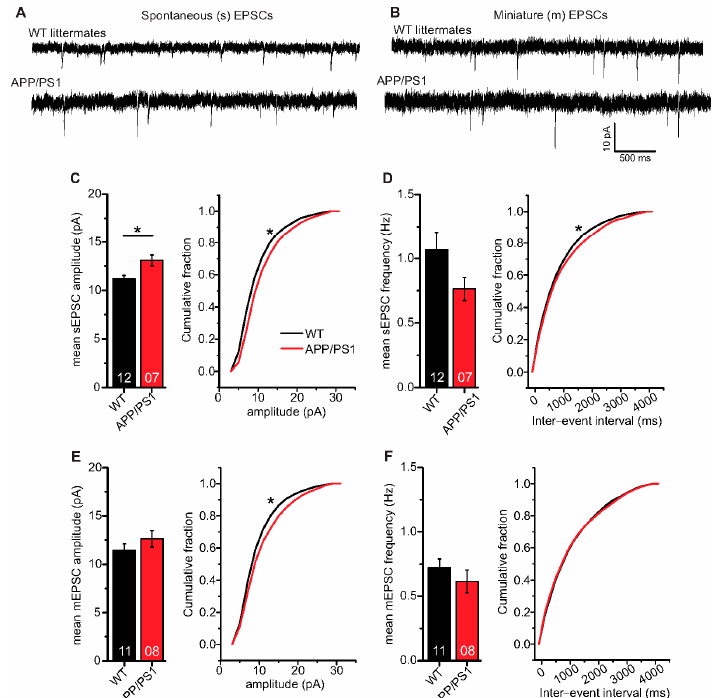
Figure 6: Spontaneous and miniature excitatory synaptic transmission in CA1 neurons of 6-month-old adult APP/PS1 mice. Whole cell patch clamp recordings (voltage clamp) of synaptic currents from CA1 neurons in acute hippocampal slices. APP/PS1 mice specified by red symbols, WT littermate mice represented by black symbols. ( A , B ) spontaneous (s) and miniature (m) EPSCs in acute hippocampal slices from WT littermate and APP/PS1 mice, respectively. ( C ) APP/PS1 mice showed significantly higher mean sEPSC amplitudes ( p = 0.008). Moreover, APP/PS1 mice showed significantly different cumulative sEPSC amplitude distribution ( p < 0.0001). ( D ) CA1 neurons from APP/PS1 animals displayed comparable mean sEPSC frequencies as WT littermate animals ( p = 0.11). However, APP/PS1 and WT mice expressed significantly different distribution of sEPSC inter-event intervals (IEIs; p = 0.005). ( E ) CA1 neurons from both WT littermate and APP/PS1 mice showed similar mean mEPSC amplitudes ( p = 0.28), but significantly different cumulative mEPSC amplitude distributions ( p < 0.0001). ( F ) CA1 neurons from APP/PS1 animals displayed similar mean mEPSC frequencies ( p = 0.25) and mEPSC IEI distribution as WT littermates ( p = 0.52). Digits in the bars show the number of recorded neurons per condition, at least from three different animals per group. Data shown as mean ± SEM. *: p < 0.05, statistical analyses were performed with two-tailed Student’s t -test (parametric data) and Mann–Whitney U-test (non-parametric data). Cumulative frequency distributions were analyzed with Kolmogorov–Smirnov